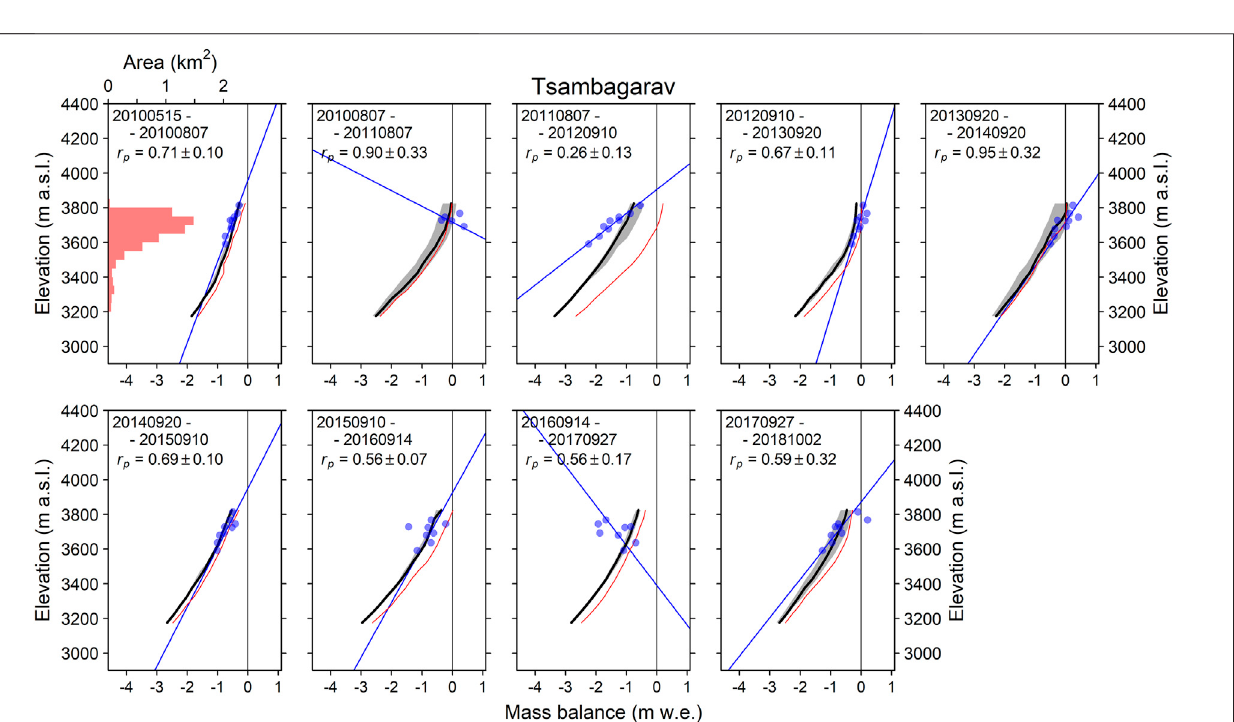
FIGURE 5 | As Figure 3 , but for Tsambagarav